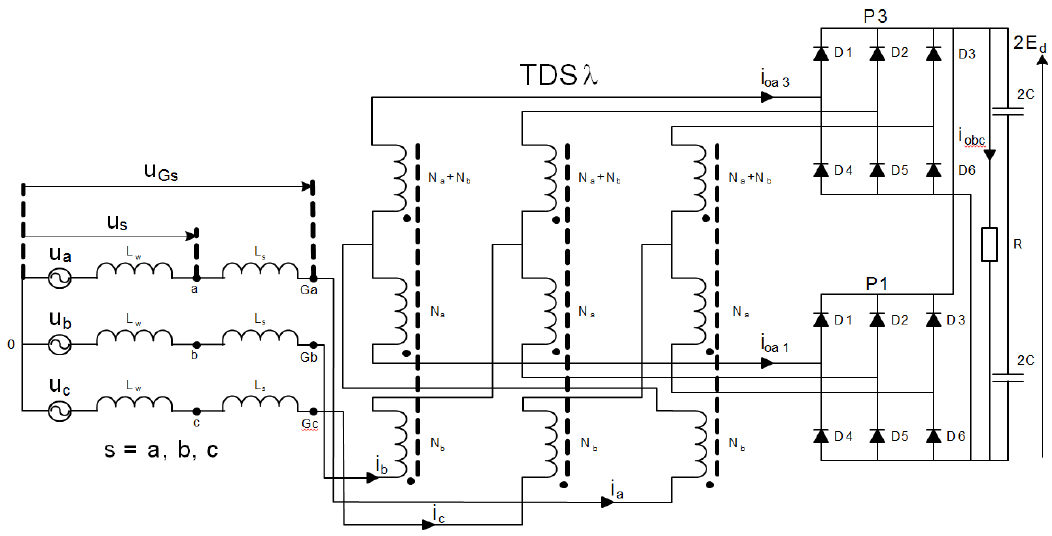
Figure 2. The 12-pulse diode rectifier using magnetically coupled reactor unit 3CRλ.